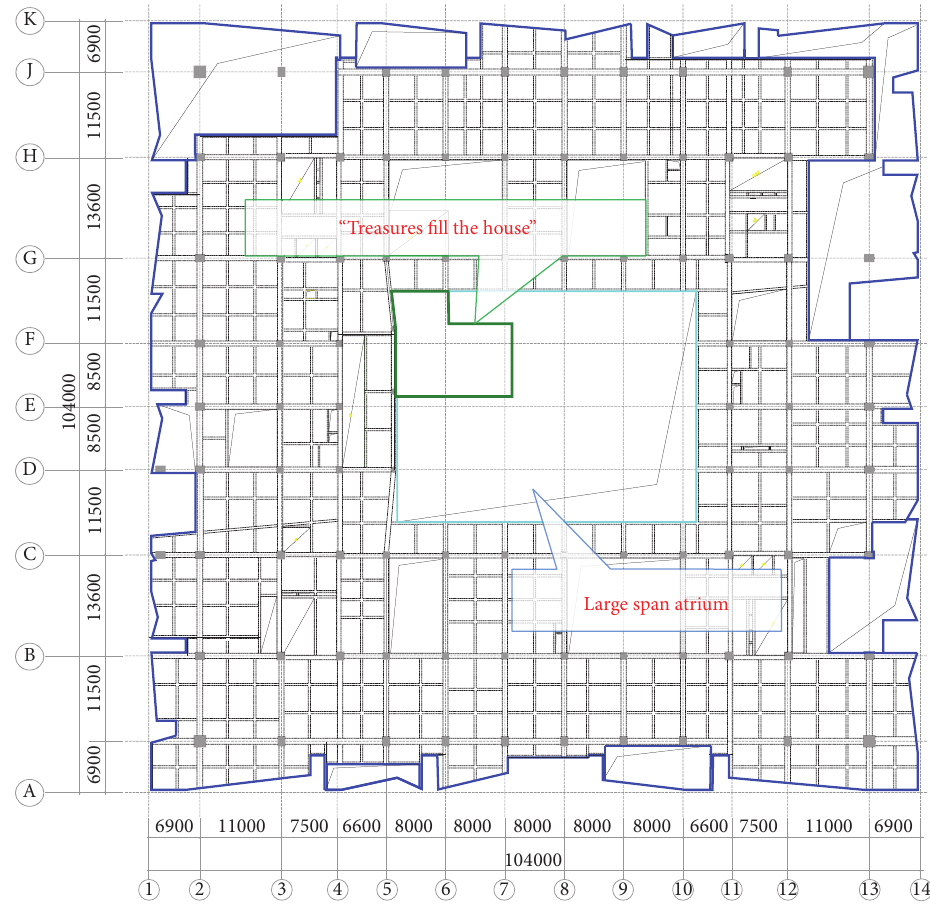
Figure 3: Structural plan layout of typical floor (unit: